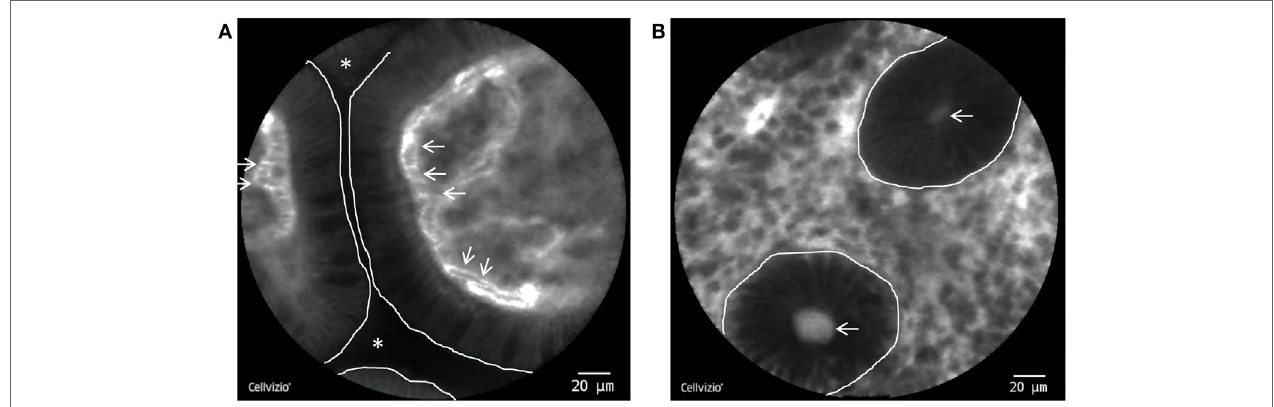
FiGURe 2 | pCLE of the terminal Ileum and the colon. (A) Single villi in the terminal ileum as visualized by pCLE. The enterocytes do not exhibit gaps or leakage and the intestinal lumen is not contrasted, consistent with an intact epithelial barrier. White line: border of the enterocytes to the intestinal lumen. White stars: intestinal lumen. White arrows: erythrocytes inside fluorescein containing capillaries. (B) Inflamed colonic mucosa from a patient with Crohn’s disease (CD). The dark round structures represent single crypts (white line) with a fluorescein leakage into the lumen (white